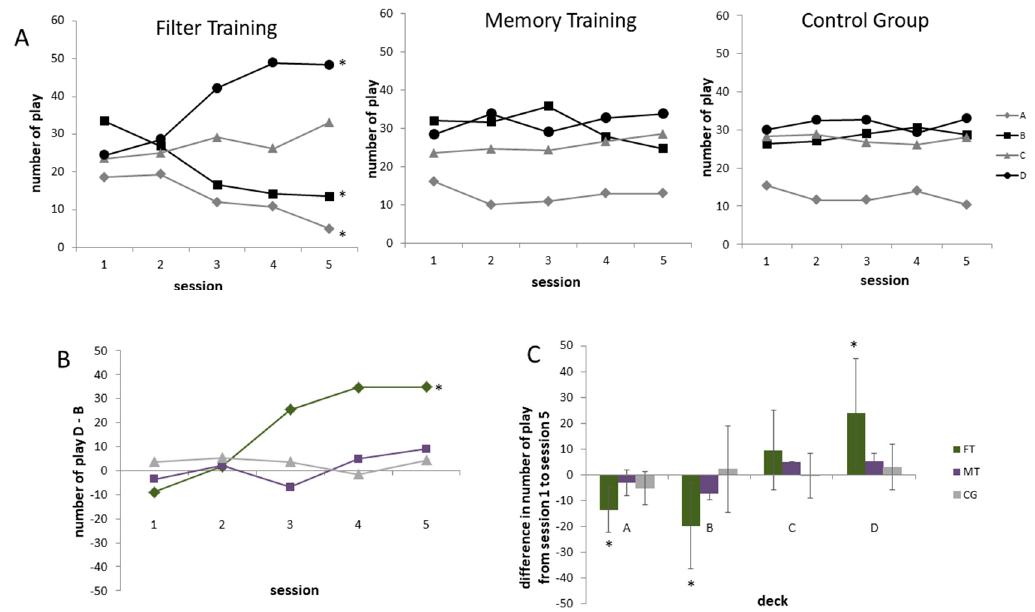
Figure 5. Deck selection over five sessions for FT, MT and CG. ( A ) The number of plays for the card decks A, B, C and D over five sessions displayed separately for FT, MT and CG. ( B ) The calculated Deck B phenomenon (deck D minus deck B) and ( C ) the difference between selected cards from deck A, B, C and D in session 1 and session 5 for all groups. * p < 0.01 after Bonferroni correction.